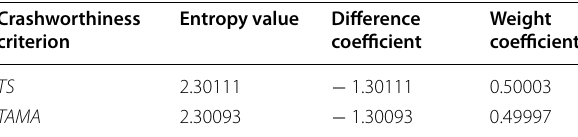
Table 12 Weight coefficients of the crashworthiness evaluation